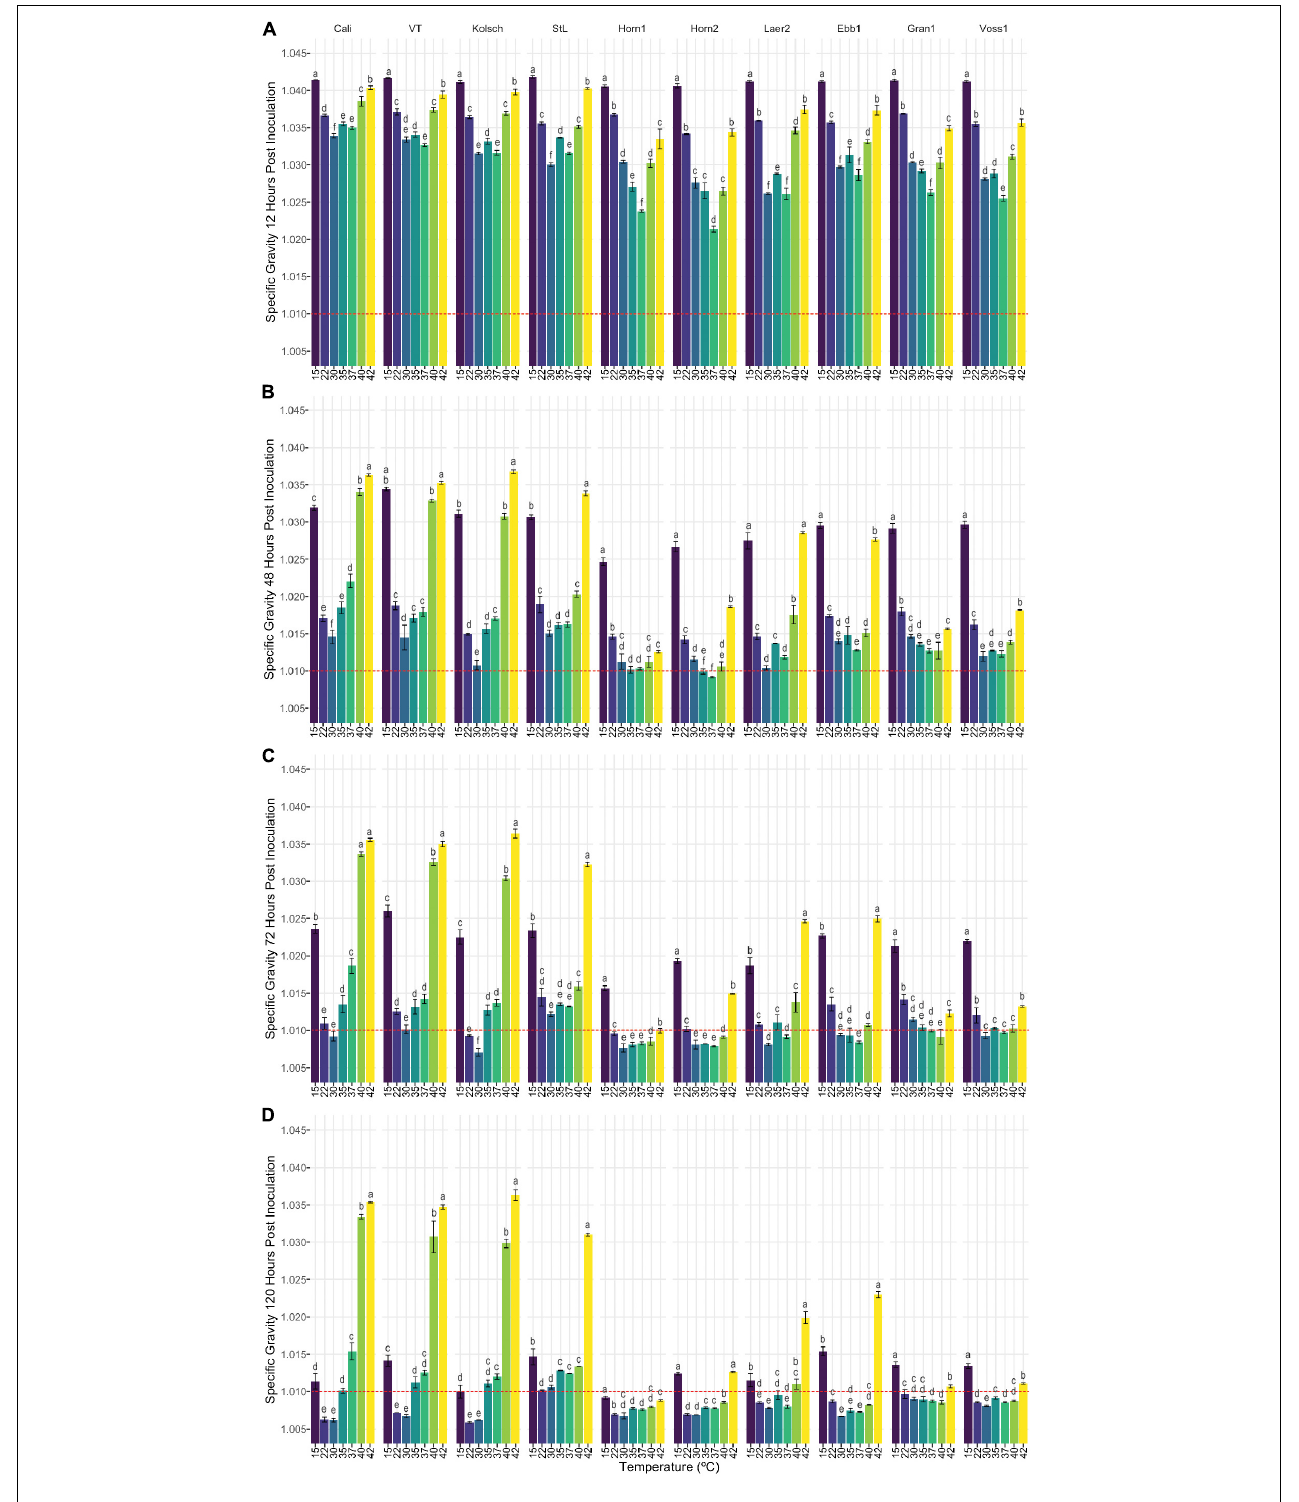
FIGURE 3 | The attenuation of kveik strains vary in a temperature-dependent manner. The data generated in Figure 2 were reorganized to present the temperature-dependent fermentation efficiencies by each of the indicated strains. Shown are specific gravities measured after (A) 12 h, (B) 48 h, (C) 72 h, and (D) 120 h of fermentation. Data points represent the mean of biological replicates ( n = 3) and error bars represent the standard deviation. Data was subjected to one-way ANOVA followed by Tukey’s HSD analysis of the mean specific gravity between temperatures for each timepoint and strain (Specific Gravity ∼ Temperature). Mean values assigned with a common letter are not significantly different by the HSD-test at the 5% level of significance within the same strain.